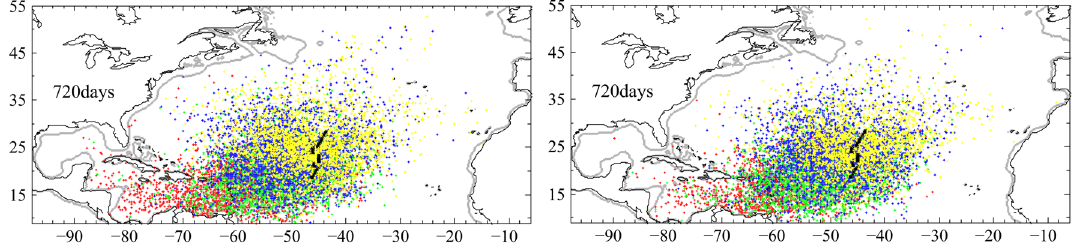
Figure 1. Distribution of v-larvae released departure at the west (left) and east (right) of Mid-Atlantic Ridge. The tracking method is the same as described in the paper, v-larvae were release within 100 km west and east of the